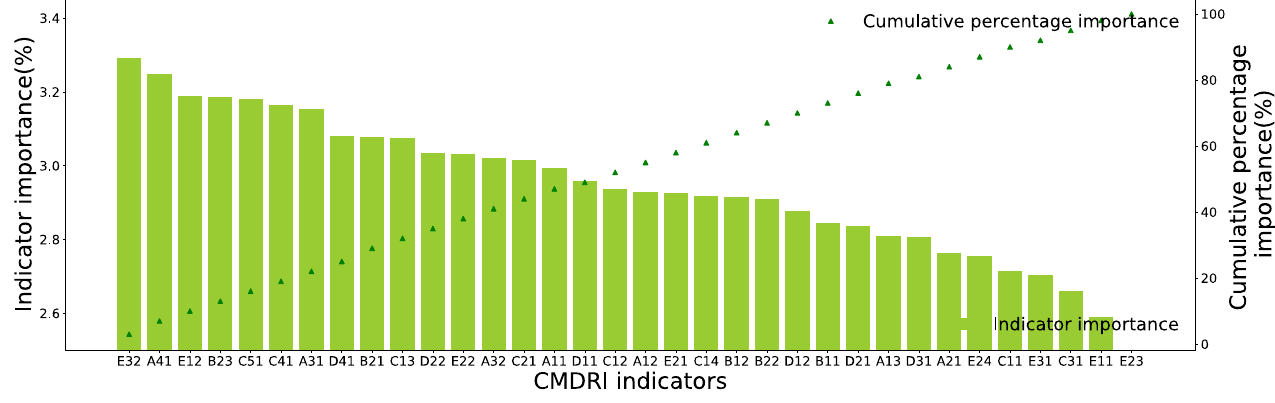
Figure 5. Key factor results of CMDRI. Specifically, economic capital has the largest share in the key factor analysis at 18.3%. The trade level, investment level, economic diversity, GDP and income were identified as key indicators influencing the CMDRI, which reflect the city’s ability to provide financial relief to the disaster-affected population and recover quickly from the disaster. Cities can- not prevent and protect themselves from marine disasters without financial investment in the early stages. Therefore, the economic capital of a city will directly mitigate the impact of disasters from the pre-disaster and post-disaster periods, and quickly restore normal socio-economic life. Human capital accounted for 18.2% of the analysis of key factors. Similar to economic capital, it can also support marine disaster resilience in all periods of marine disaster risk management. This study identifies demographics, educational attain- ment, gender structure and age structure as important factors in human capital. Among them, reducing the employment burden population, increasing the level of education, in- creasing the number of people per household and increasing the young adult labor can